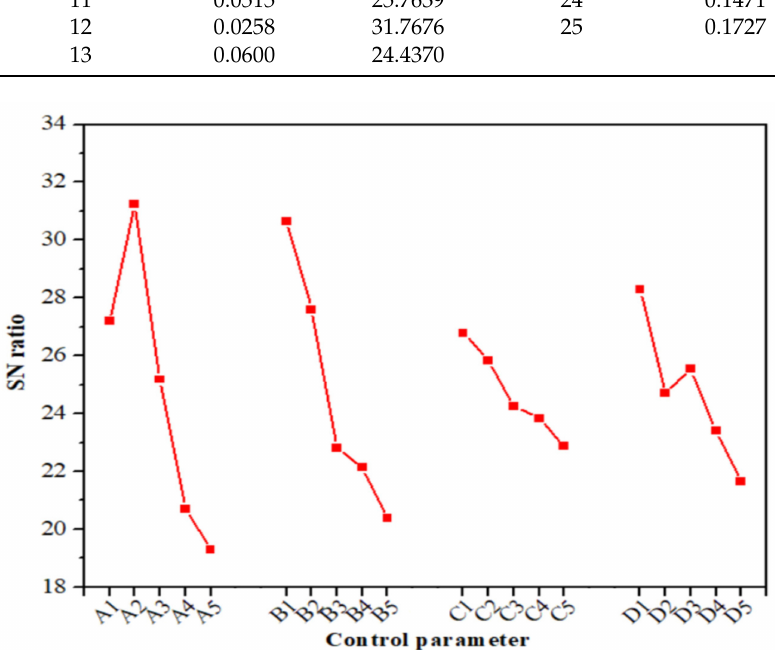
Figure 5. Main parameter effects for various SN ratio values of volumetric